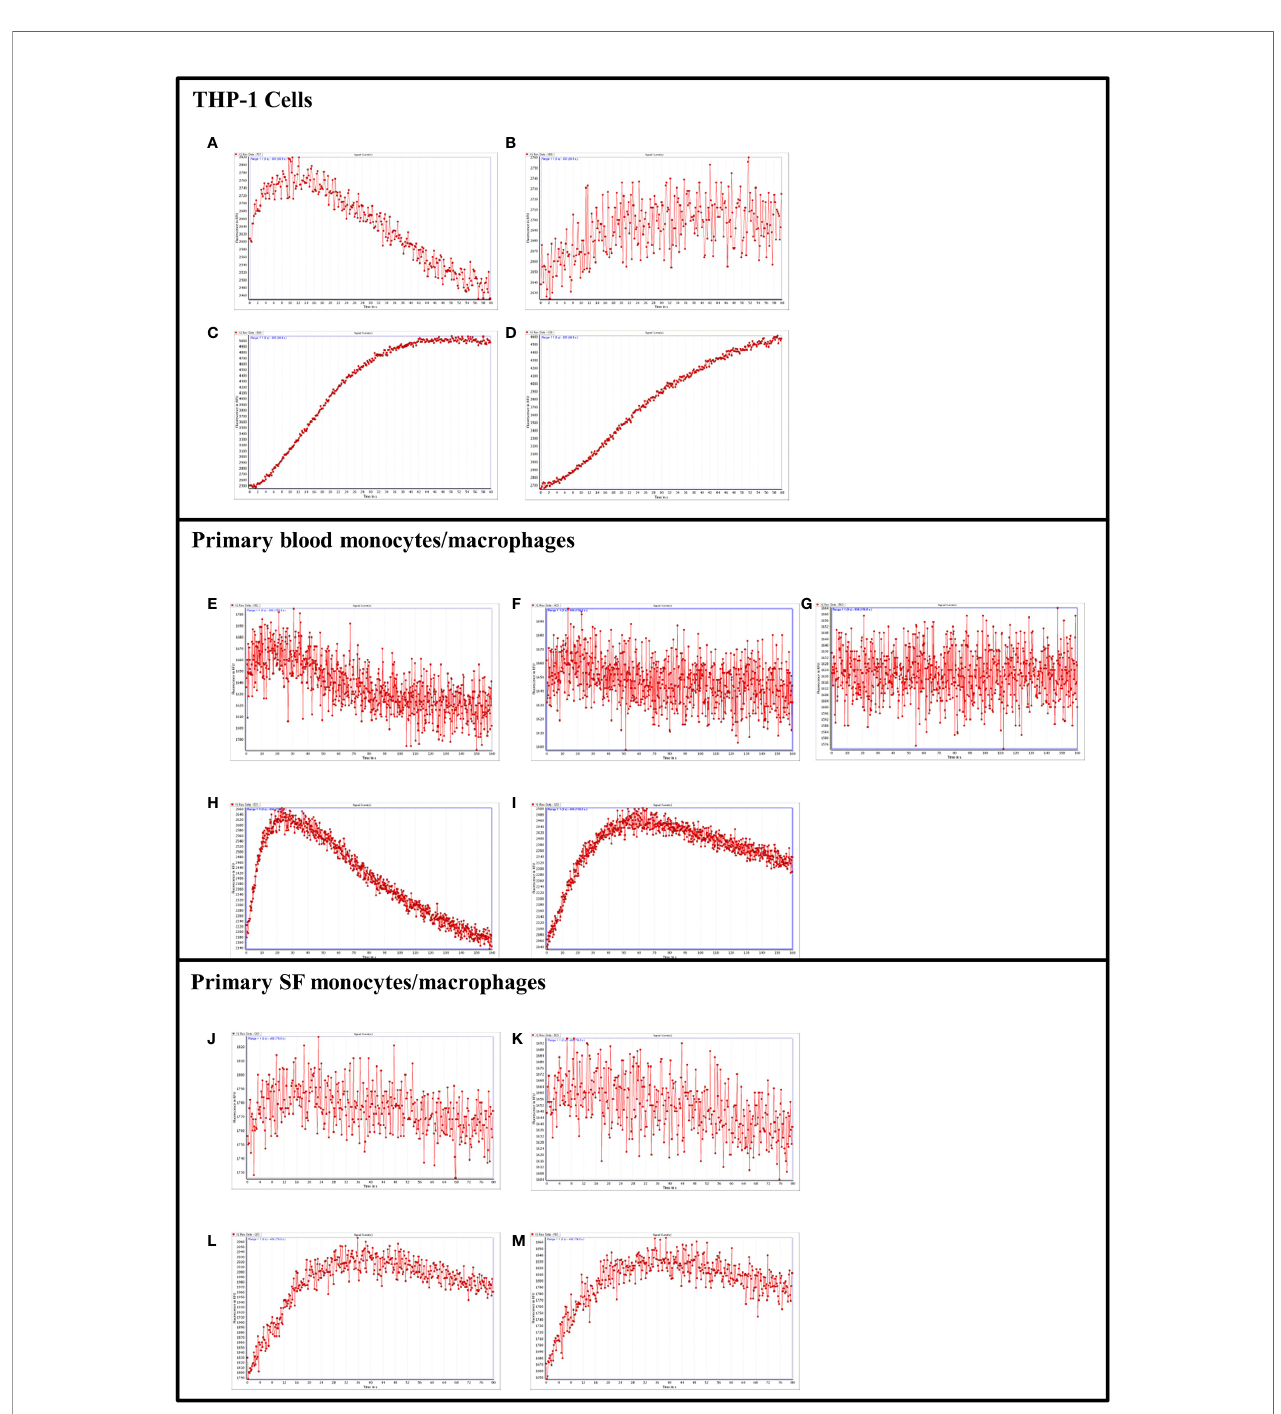
FIGURE 8 | PAR2 and tryptase-6 trigger calcium signals in THP-1 cells and PsA PAR2+ monocytes/macrophages. Calcium signaling assay using the fl uorescent indicator, Fluo-4 AM, was used to con fi rm the signaling potential of PAR2 and determine whether tryptase-6 can elicit a calcium response via PAR2 in THP-1 cells and primary monocytes/macrophages from PsA patients. Stimulation with 2fLI in THP-1 (150 µM, A ) or primary blood PAR2+ monocytes/macrophages (100 µM, E ) was inhibited 12% (B) and 8% (F) by 1 µM of I-191, respectively. In blood cells, 2 µM of I-191 inhibited this signal by 27% (G) . Stimulation of THP-1 cells (C) and primary cells (H) with volume equivalent to 44.8 or 89.6 FU/min/ng tryptase-6 isolated with the antibody af fi nity column from PsA SF, respectively, caused an elevation of intracellular calcium. Treatment with 1 µM of I-191 caused a 15% (D) and 13% (I) inhibition of this signal, respectively. Similarly, in primary SF monocytes/macrophages, 2fLI (200 µM, J ) and volume equivalent to 44.8 FU/min/ng tryptase-6 (L) caused a calcium fl ux that was inhibited 51% (K) and 40% (M) by 1 µM of I-191, respectively. Calcium traces are shown with agonists (2fLI and tryptase-6) added at time zero with or without pre-treatment with I-191 (x- axis=time post addition of agonist, y-axis=units of fl uorescence due to calcium